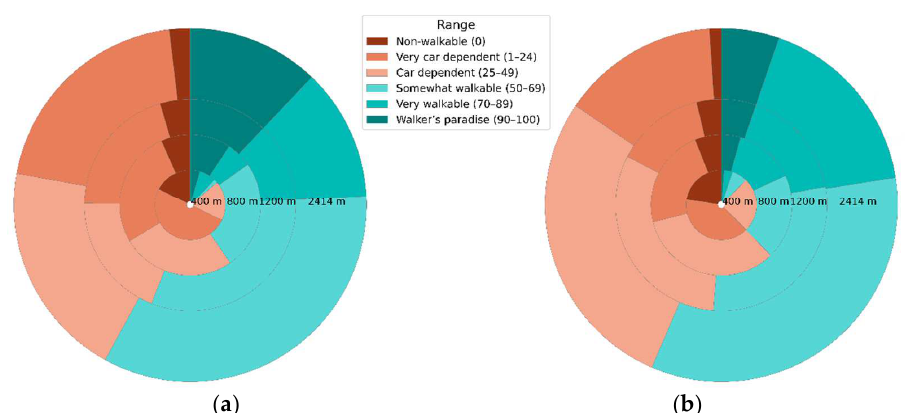
Figure 10. Distribution of population according to WS for different search radii in Hradec Kralove ( a ) and Ostrava ( b ). Table 4. Distribution of WS for different search radii in Hradec Kralove.